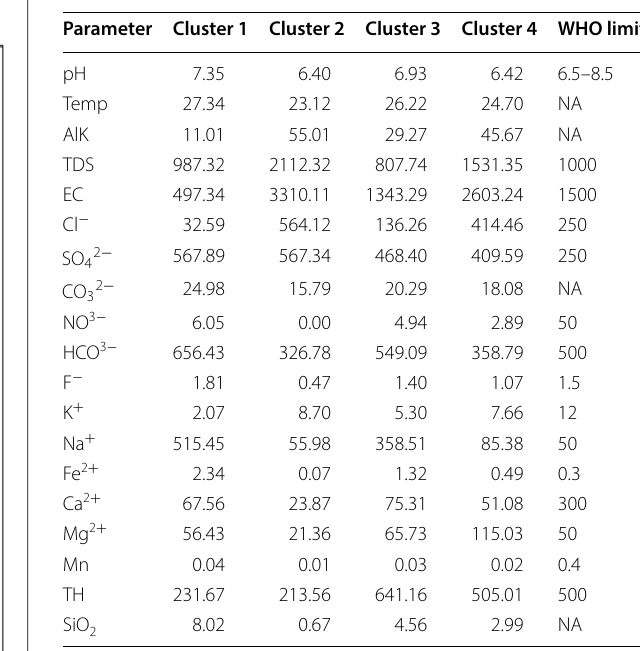
Table 5 Hydro-chemical features of cluster grouping